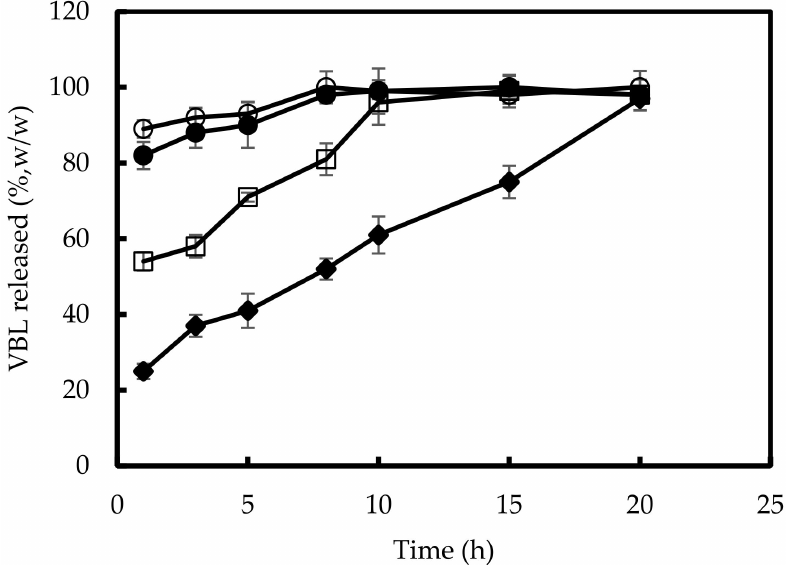
Figure 6. Release profile of VBL from 15% VBL-CS/HY NPs as a function of time and different pH values. Open squares: pH = 5; closed diamonds: pH = 7.4. In addition, the diffusion of free VBL at pH = 7.4 (closed circles) and at pH = 5.0 (open circles) are reported. See text for details. Results are presented as the means of six different experiments ±